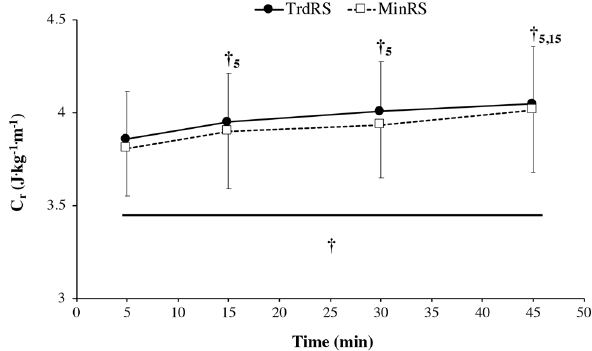
Figure 1. Net energy cost (C r ) vs. time during the two experimental conditions [traditional cushioned (TrdRS) and minimalist (MinRS) running shoes]. Values are mean ± SD (n = 16). † indicates a significant time effect ( P ≤ 0.05); † 5 represents a significant difference from 5 min; † 15 notes a significant difference from 15